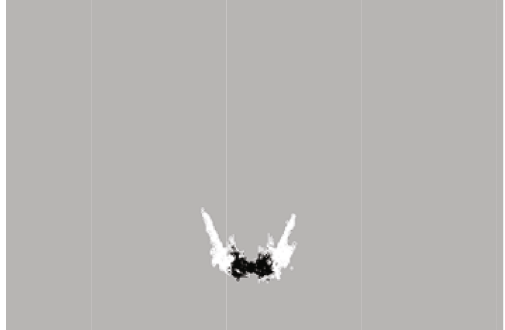
Figure 7: 200-mm borehole acoustic emission destruction cloud